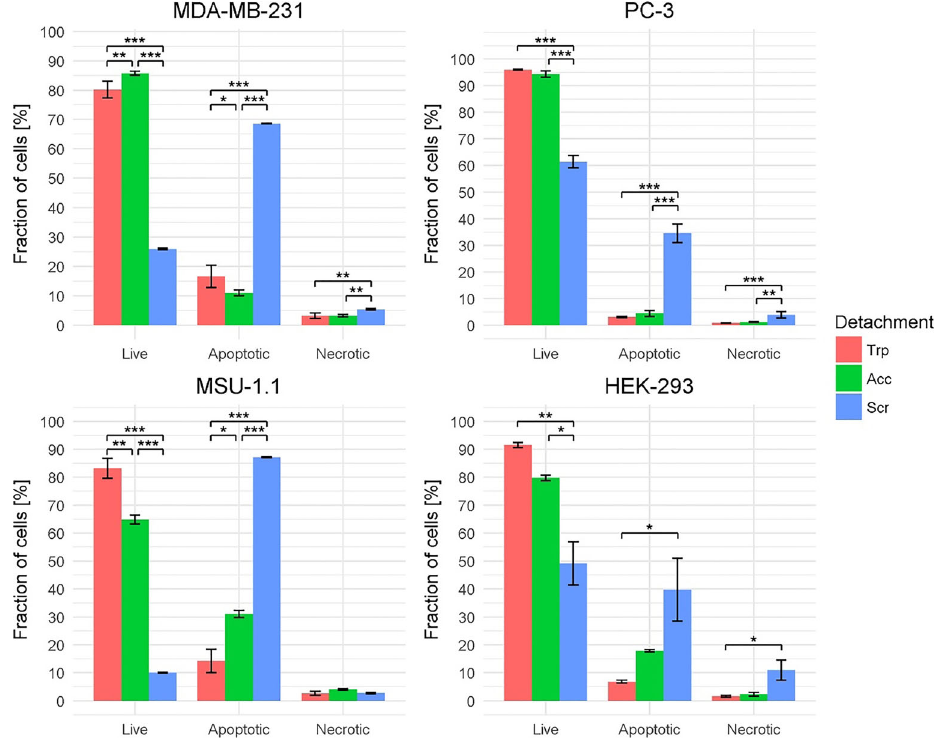
Figure 4. In fl uence of three cell harvesting methods [trypsin (Trp), accutase treatment (Acc), scraping by rubber scraper (Scr)] on four adherent cell lines. Data are reported as means ± SD. *P o 0.05, **P o 0.01, ***P o 0.001 (ANOVA and Tukey ’ s HSD